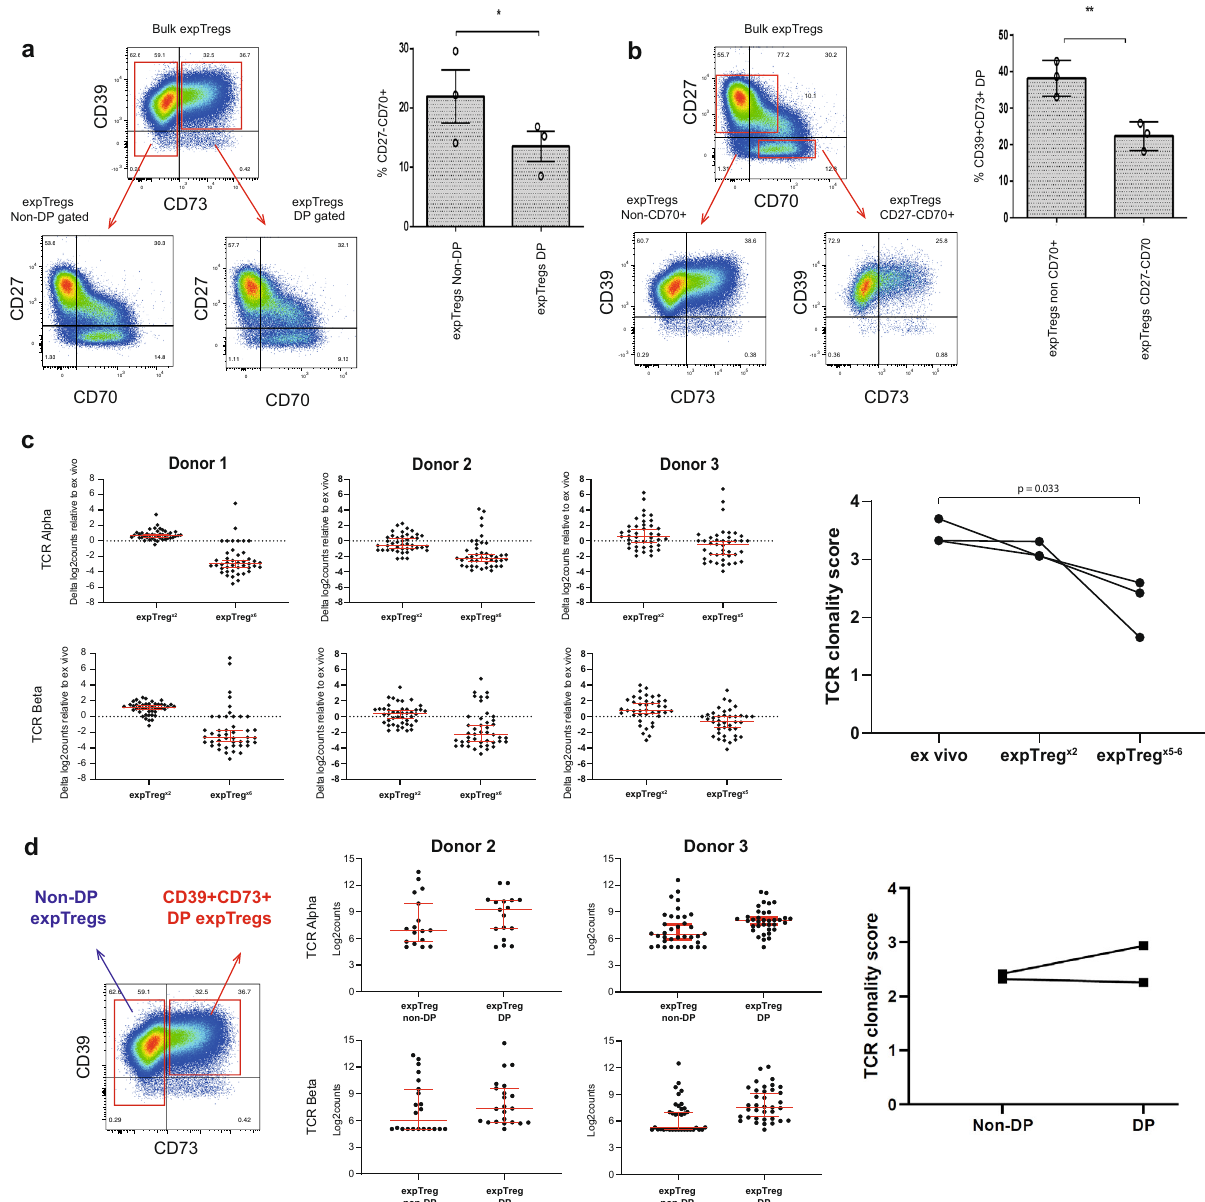
Fig. 6 Multiple rounds of Treg expansion leads to reduced TCR diversity. a Analysis of CD27 − CD70 + expTregs within gated CD39/CD73 double- positive expTregs and non-double-positive expTregs. Gating strategy is shown for one representative donor and summary data for three donors. b Analysis of CD39/CD73 co-expression within CD27 − CD70 + expTregs and non-CD27 − CD70 + expTregs. Gating strategy is shown for one representative donor and summary data for three donors. One-way ANOVA followed by Tukey ’ s multiple comparison testing. * P < 0.05, ** P < 0.01, *** P < 0.001, **** P < 0.0001. c Expression of TCR alpha and TCR beta variable chains in expTreg ×2 and expTreg ×5 – 6 relative to their ex vivo mTreg counterpart ( n = 3 donors, left plots. Red error bars show median with 95% CI, dotted green line denotes the mean of the ex vivo data set).TCR clonality is reduced in expTregs ×5 – 6 as the mean expression of all alpha or beta chains is below zero, whereas only a few dominant TCR chains are expanded (values above zero). Log2 counts are shown in Supplementary Fig. 7. TCR clonality score of ex vivo mTregs vs. expTregs after 2 or 5 – 6 cycles of expansion ( n = 3 donors, right plot) calculated using the expression of the variable TCR beta chain. d TCR clonality of sorted CD39 + CD73 + double positive (DP Tregs) vs non-double-positive Tregs in two donors and TCR clonality score calculated using expression of the variable TCR beta